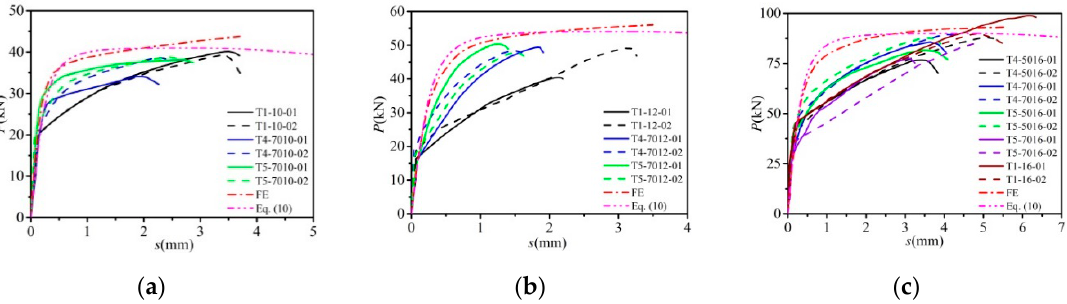
Figure 4. Load-displacement curves for push-off tests: ( a ) specimens of 10 mm; ( b ) specimens of 12 mm; ( c ) specimens of 16 mm.